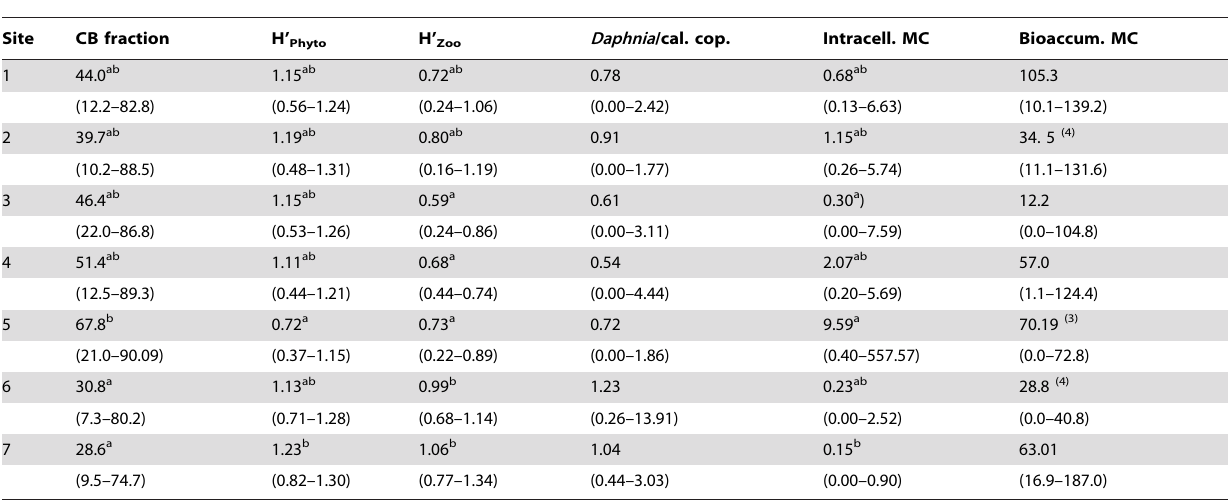
Table 4. Phytoplankton, cyanobacteria and microcystin parameters.